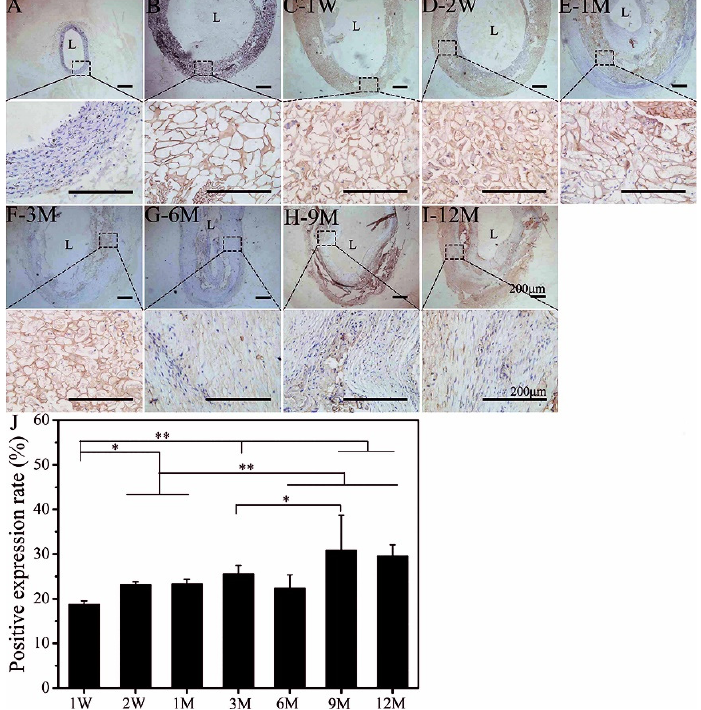
Figure 4. Immunoenzyme staining of COL-III. ( A ): Autogenous carotid artery; ( B ): non-implanted SFTS; ( C–I ): different time points after implantation of SFTSs; ( J ): semi-quantitative results of positive expression; “L” represents the lumen. The scale bar is 200 μ m. “*” represents p < 0.05; “**” represents p < 0.01.